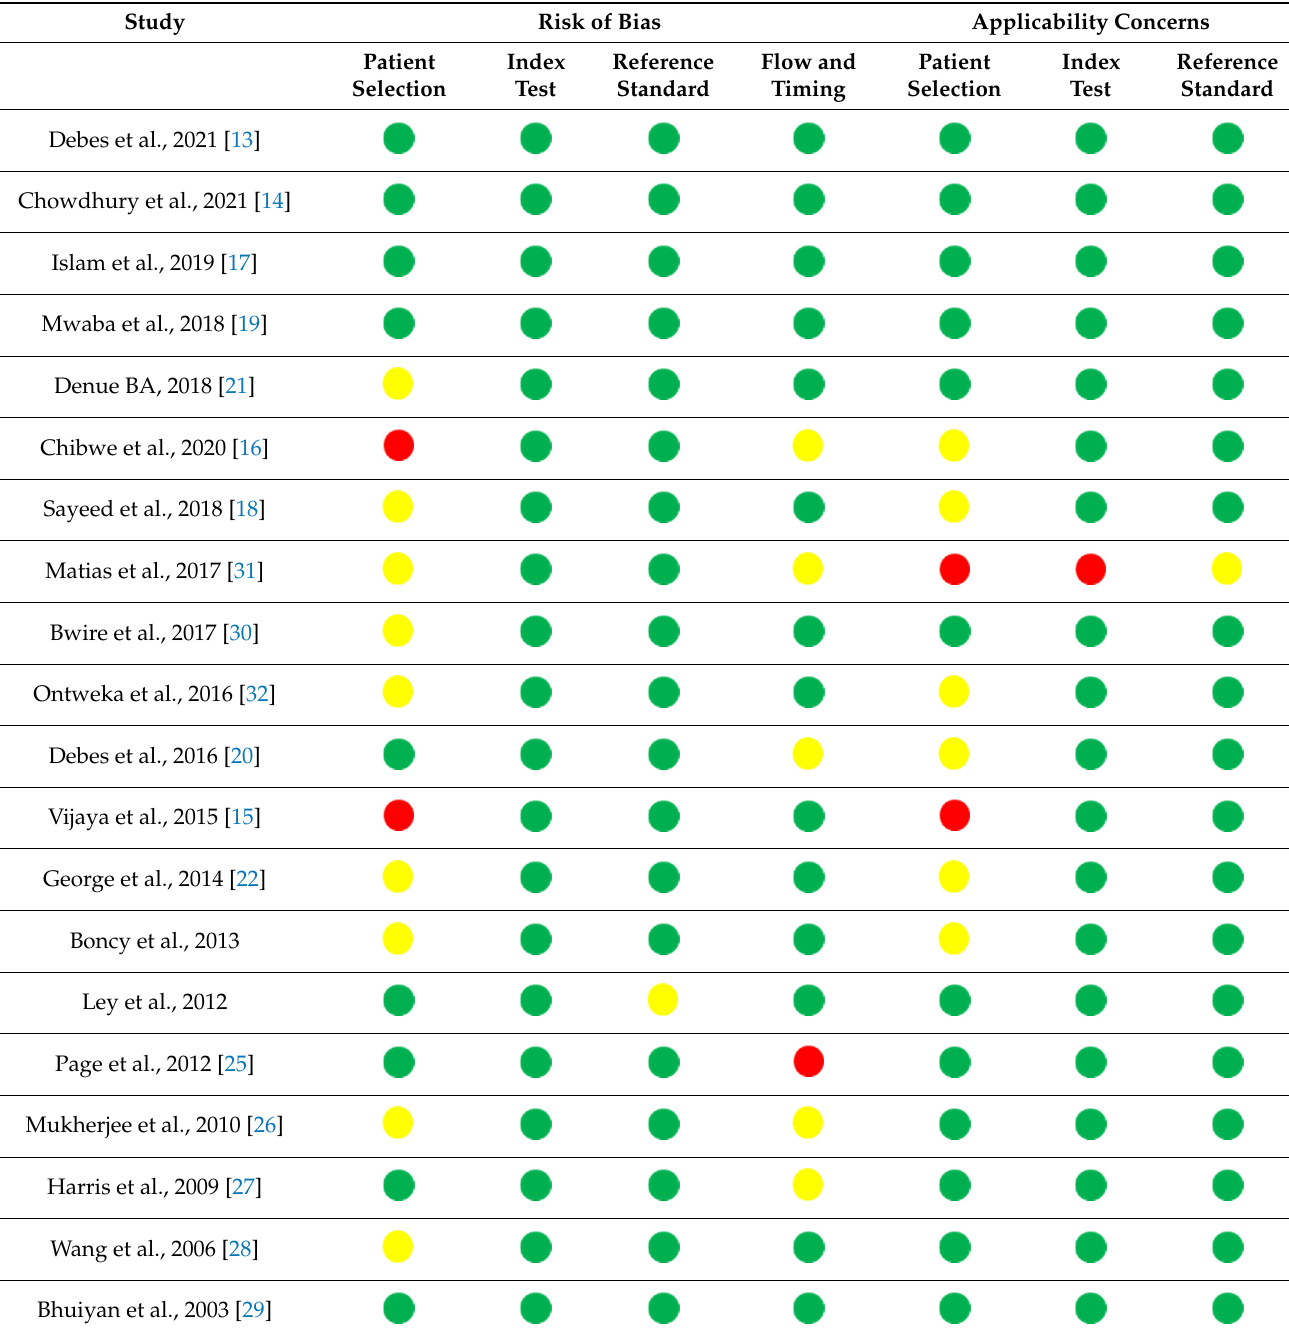
Green represents low risk of bias, yellow represents unclear risk of bias, and red represents high risk of